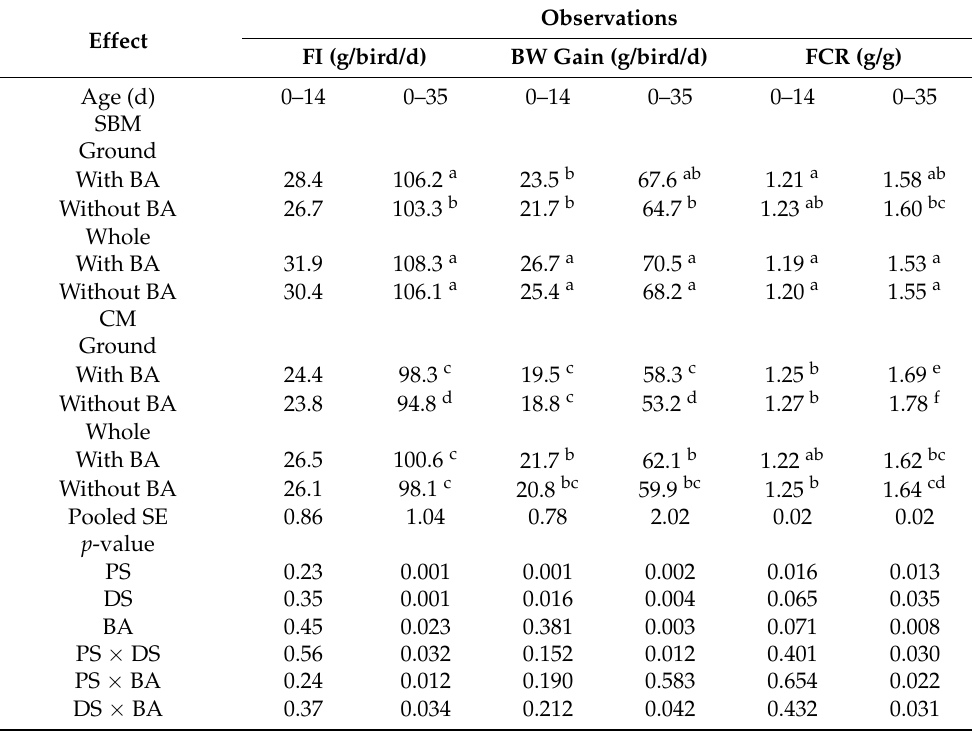
Table 2. Effects of protein source (PS), diet structure (DS) and butyric acid (BA) supplementation on feed intake (FI), body weight gain (BWG) and feed conversion ratio (FCR) in broilers 1